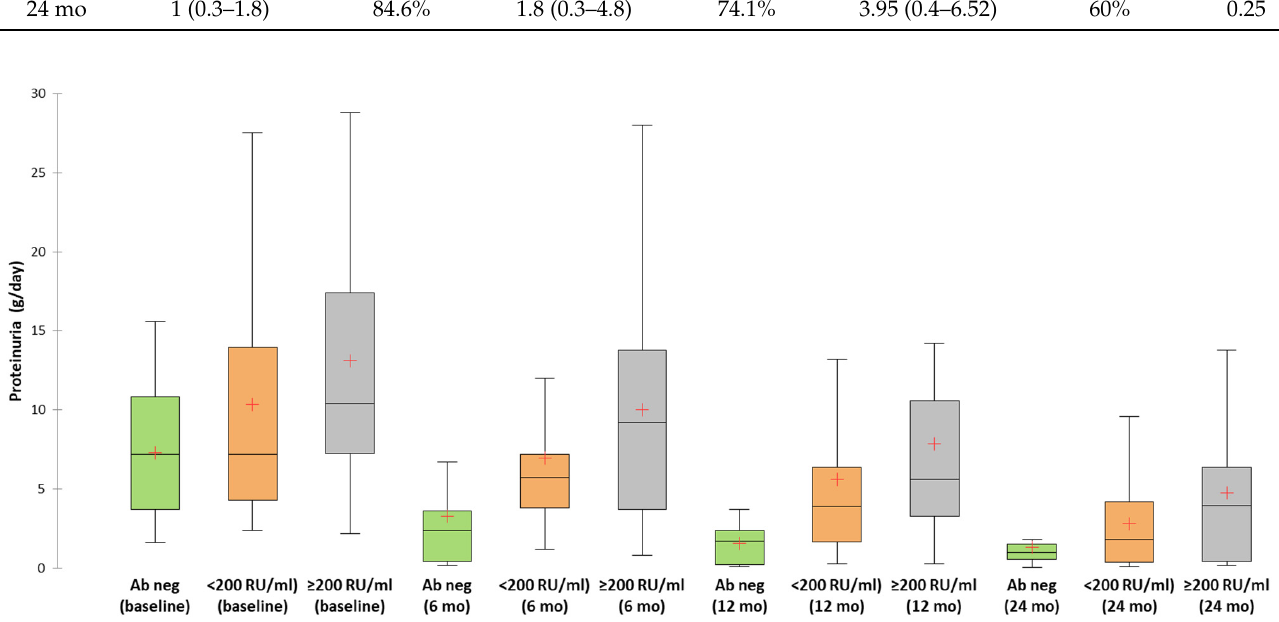
Figure 1. Evolution of proteinuria according to anti-PLA2R antibody status.